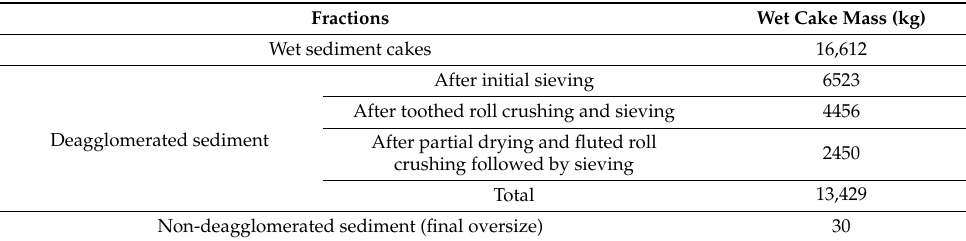
Table 8. Mass balance of the ALS sediment deagglomeration process. Fractions Wet Cake Mass (kg)